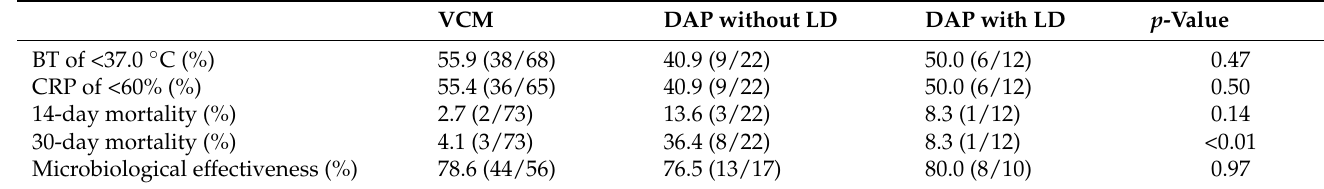
Table 5. Clinical and microbiological effectiveness of patients receiving vancomycin and daptomycin treatments with or without a loading dose.